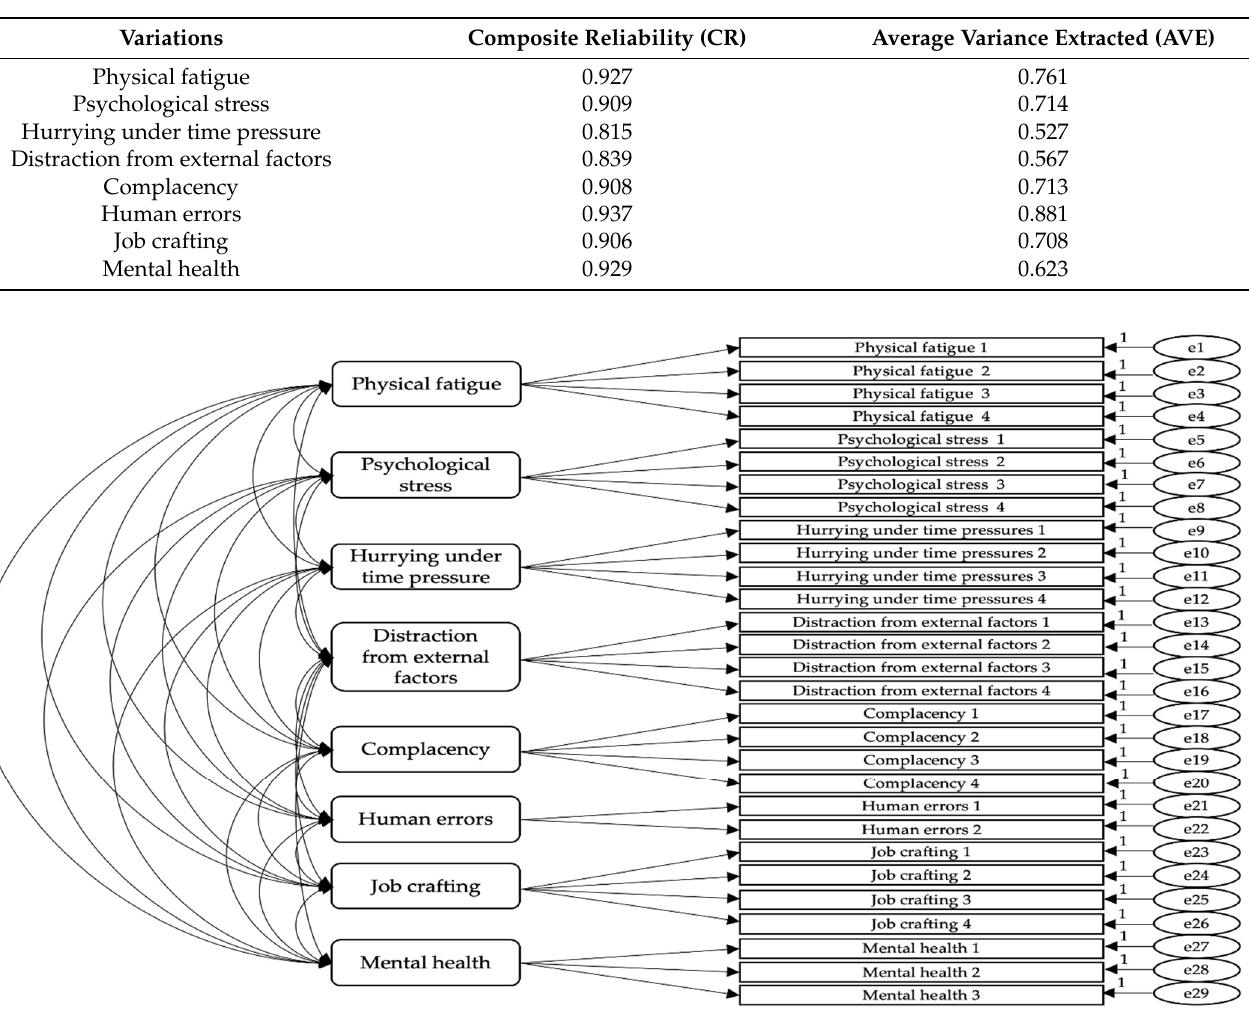
Table 2. Results of CFA and Reliability Analysis.